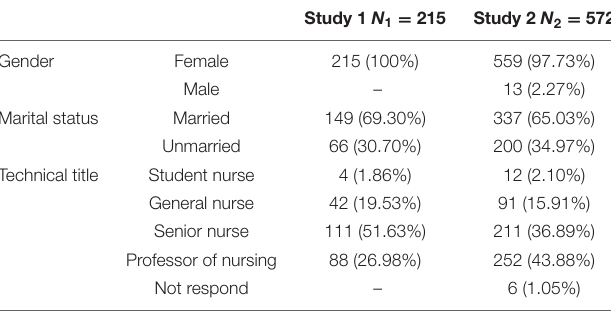
TABLE 1 | Descriptive statistics for all samples ( N 1 = 215, N 2 =